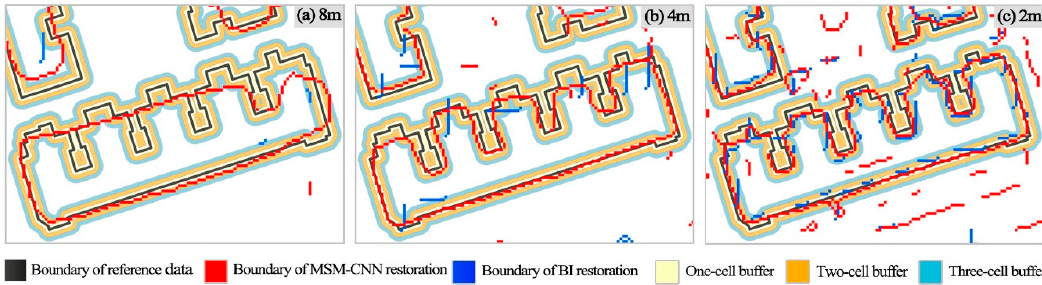
Figure 11. Building boundaries extracted from the reconstructed DEMs: ( a , b , c ) DEMs reconstructed from the 8, 4, and 2 m DEMs, respectively. One-cell, two-cell, and three-cell buffers are respectively the zones with widths of 1, 2, and 3 times the reconstructed cell size around the reference boundary lines.